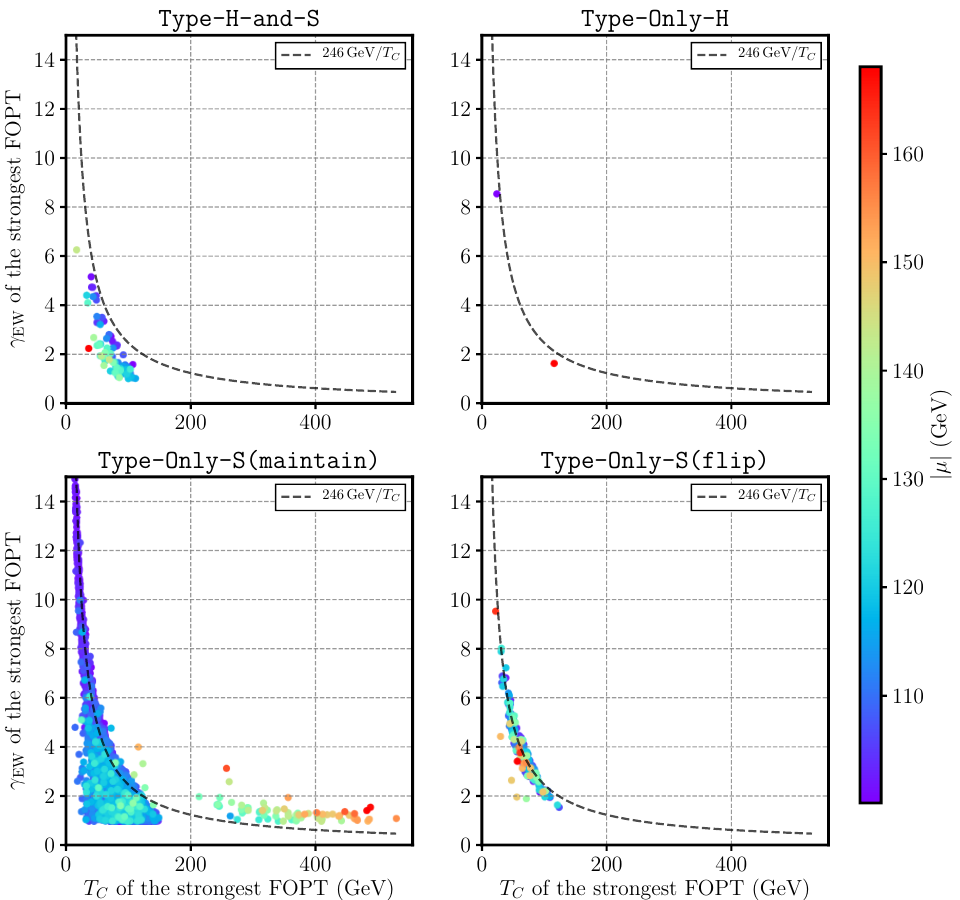
Figure 8 . The critical temperature and order parameter for the strongest PTs for samples for which the strongest FOPT does not end in the SM vacuum. The points are colored by the e(cid:11)ective (cid:22)